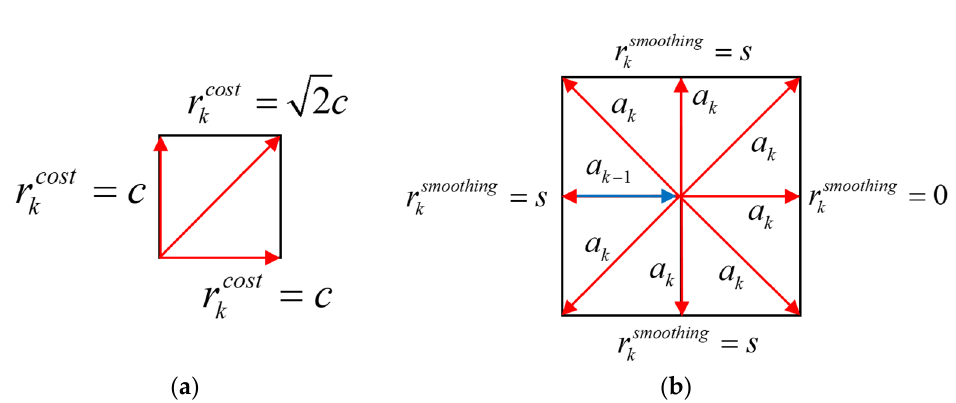
Figure 4. The schematic of the reward for the energy cost and the reward for path smoothing: ( a ) reward for energy cost and ( b ) reward for path smoothing.